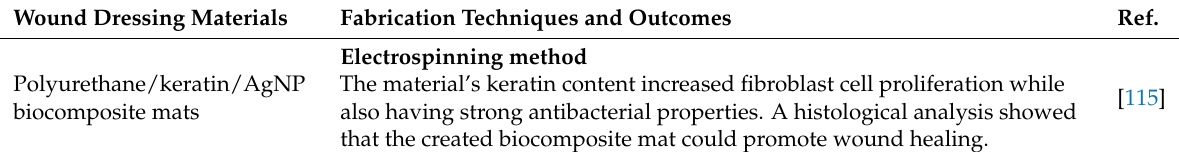
Table 1. Various forms of fabricated biomaterials for wound healing